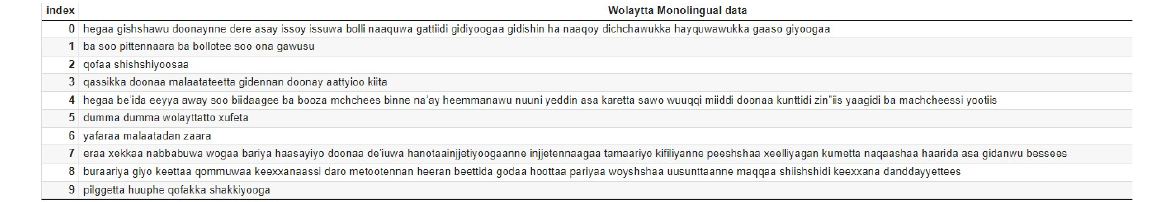
Figure 6. Sample texts from Wolaytta monolingual dataset. Table 3. Manually translated sample text for monolingual text Figure 6.